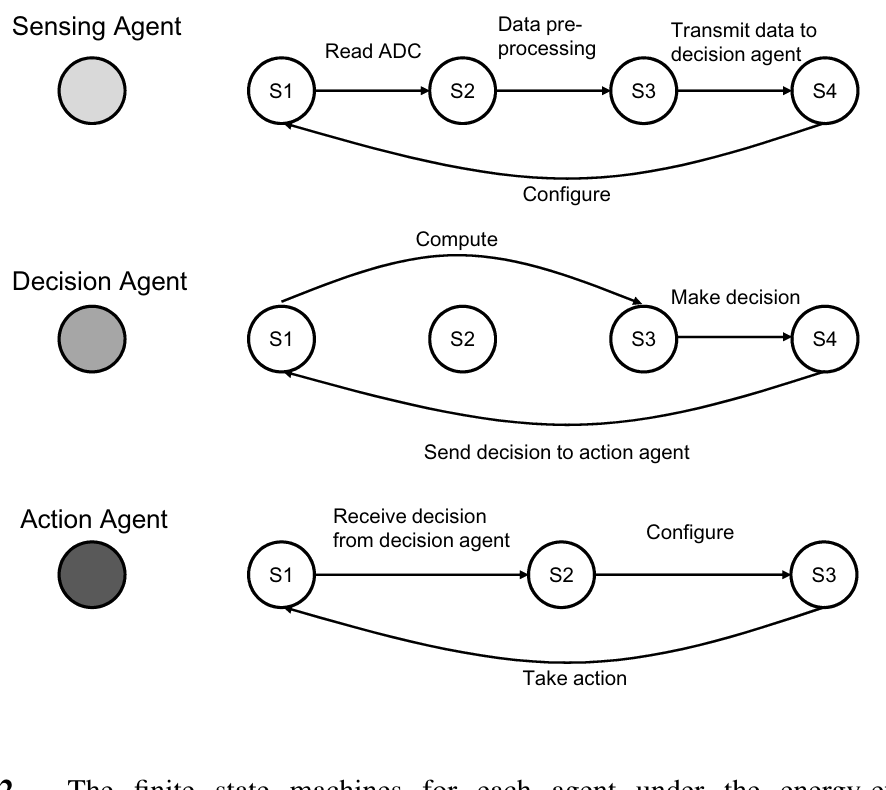
Figure 11. The finite state machines for each agent under the response-time-oriented policy.